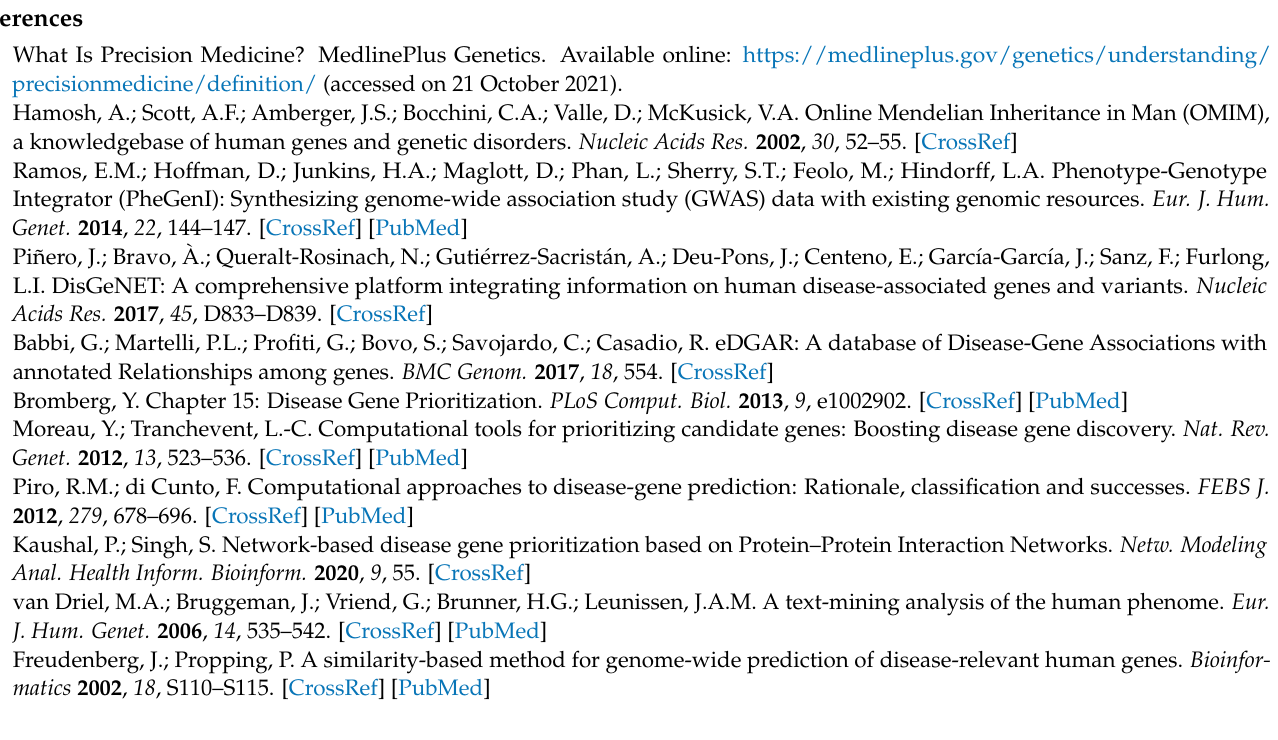
( warm seeds and putative disease genes) for crohn disease , Figure S12: Largest connected component (LCC) of the predicted disease module ( warm seeds and putative disease genes) for diabetes mellitus type 2 , Figure S13: Largest connected component (LCC) of the predicted disease module ( warm seeds and putative disease genes) for head and neck neoplasms , Figure S14: Largest connected component (LCC) of the predicted disease module ( warm seeds and putative disease genes) for leukemia, myeloid , Figure S15: Largest connected component (LCC) of the predicted disease module ( warm seeds and putative disease genes) for lipid metabolism disorders , Figure S16: Largest connected component (LCC) of the predicted disease module ( warm seeds and putative disease genes) for lupus erythematosus , Figure S17: Largest connected component (LCC) of the predicted disease module ( warm seeds and putative disease genes) for lysosomal storage diseases , Figure S18: Largest connected component (LCC) of the predicted disease module ( warm seeds and putative disease genes) for multiple sclerosis , Figure S19: Largest connected component (LCC) of the predicted disease module ( warm seeds and putative disease genes) for muscular dystrophies , Figure S20: Largest connected component (LCC) of the predicted disease module ( warm seeds and putative disease genes) for psoriasis , Figure S21: Largest connected component (LCC) of the predicted disease module ( warm seeds and putative disease genes) for spinocerebellar degenerations , Table S1: disease genes and putative genes for rheumatoid arthritis , Table S2: disease genes and putative genes for colorectal cancer